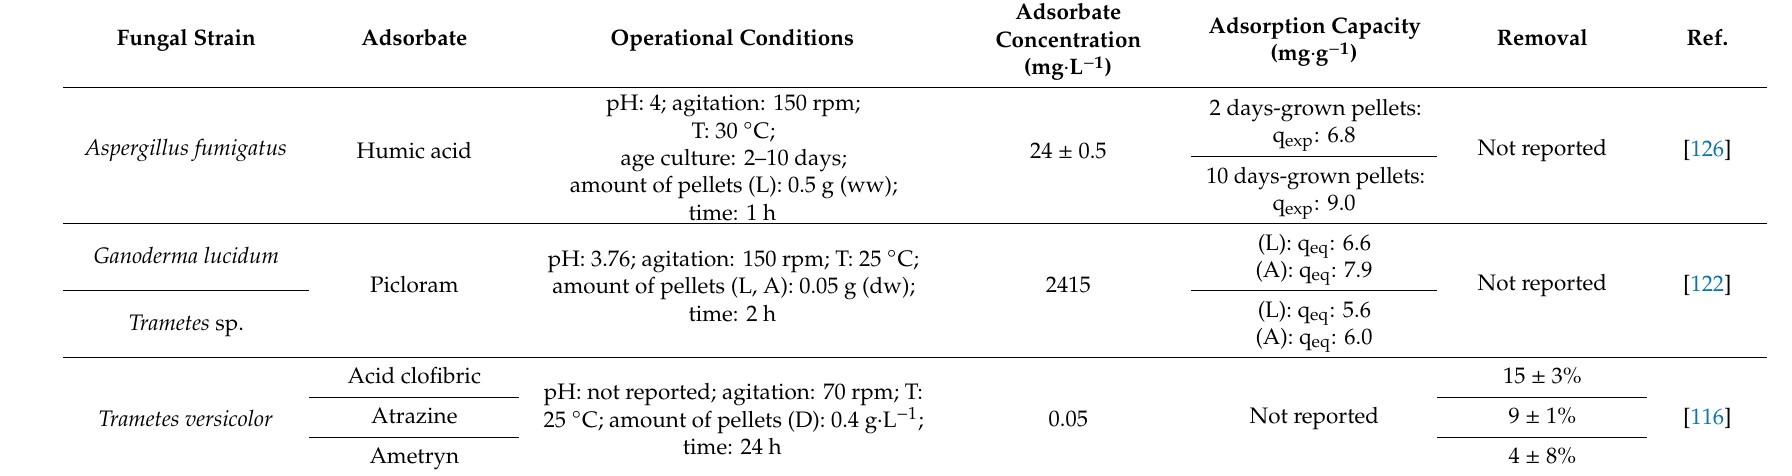
Table 5. Biosorption of other organic compounds by fungal